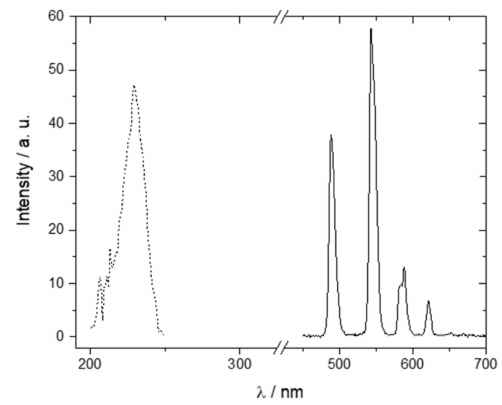
Figure 1. Excitation (dotted line, λ em = 545 nm) and emission fluorescence spectra of TbL in the solid state (298K, λ exc = 230 nm, slit width 5